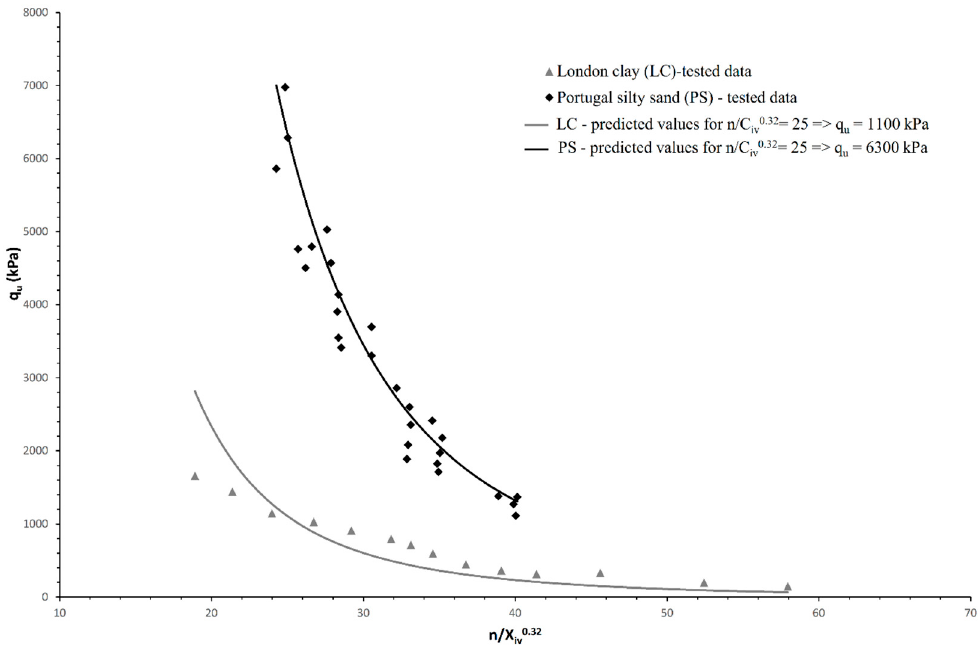
Figure 8. Curve obtained using Equation (7) and laboratory testing data for Portugal Silty sand [47] cement blend tested for unconfined compression and London Clay [47] plus Portland cement blend tested for unconfined compression.